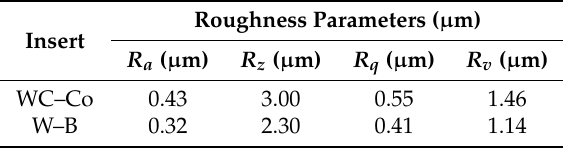
Table 4. Roughness parameters of cutting tools, cut-off 0.25 mm.